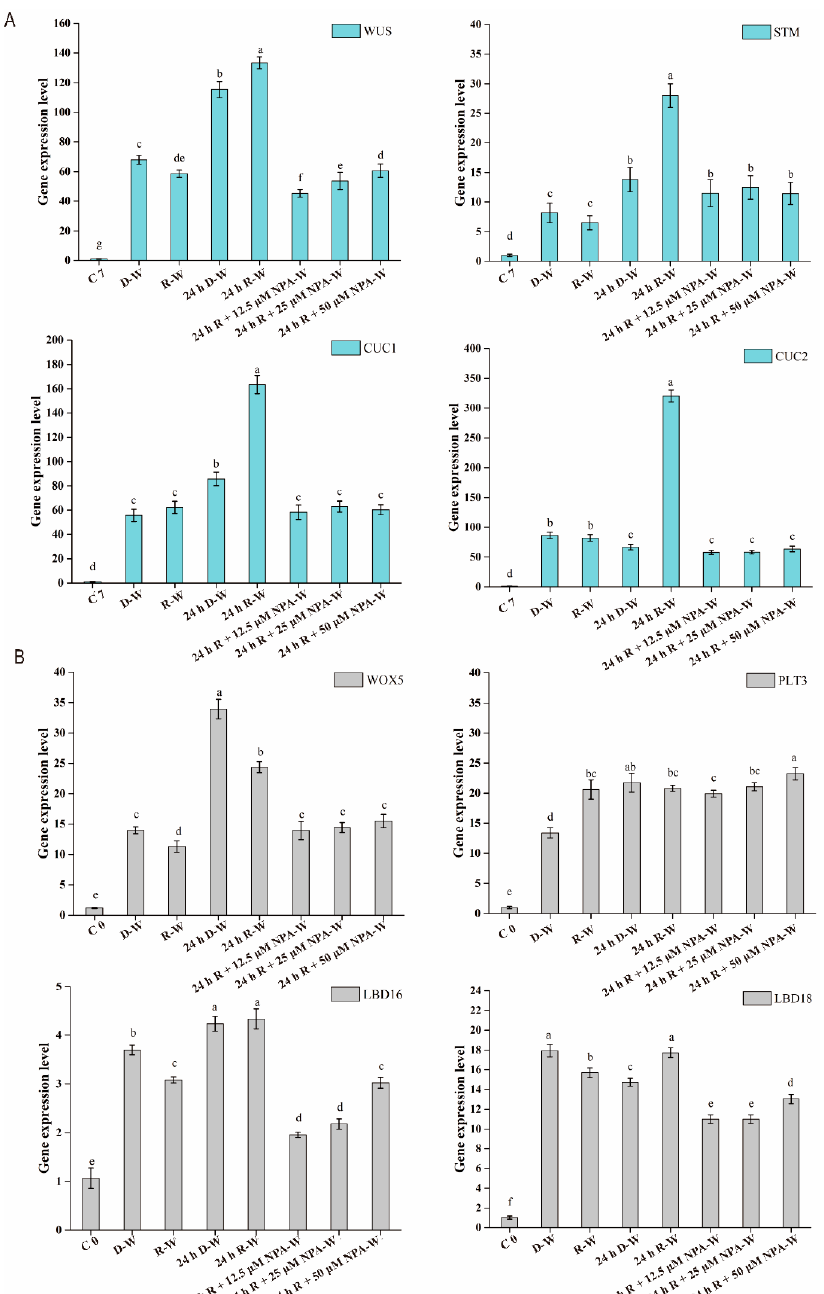
Figure 5. Expression patterns of shoot regeneration marker genes and callus development marker genes under different treatments. ( A ) Expression patterns of marker genes associated with shoot regeneration at day 7 on the CIM and SIM, respectively. ( B ) Expression patterns of marker genes involved in callus development at 7 day on the CIM. C0, root explants on the CIM at day 0, gene expression levels in excised roots at CIM day 0 was set to 1 for quantification of relative expression. C7, root explants on the CIM at day 7, gene expression levels in excised roots at CIM day 7 was set to 1 for quantification of relative expression. Error bars indicate the standard deviation from three independent experiments. A total of 30 individual calluses were collected for qPCR expression analysis for each biological replicate. The least significant difference method (LSD) was used for a significance test ( p < 0.05); di ff erent lowercase letters represent statistical di ff erences in pairwise comparisons between LSD test groups ( p <